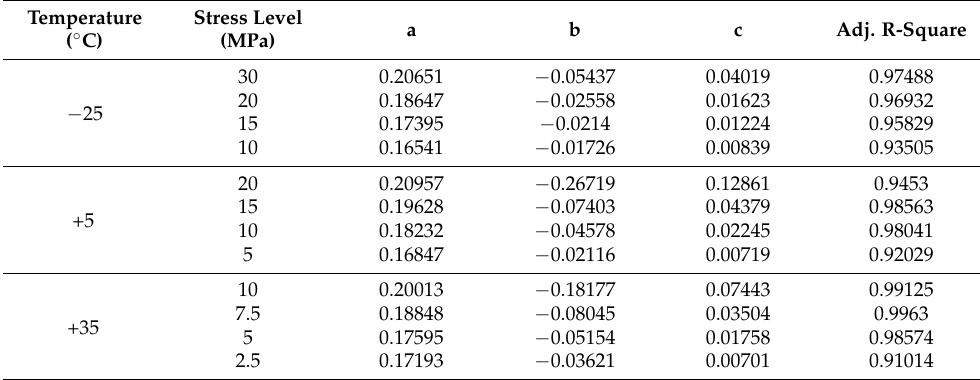
Table 3. Creep model parameters.